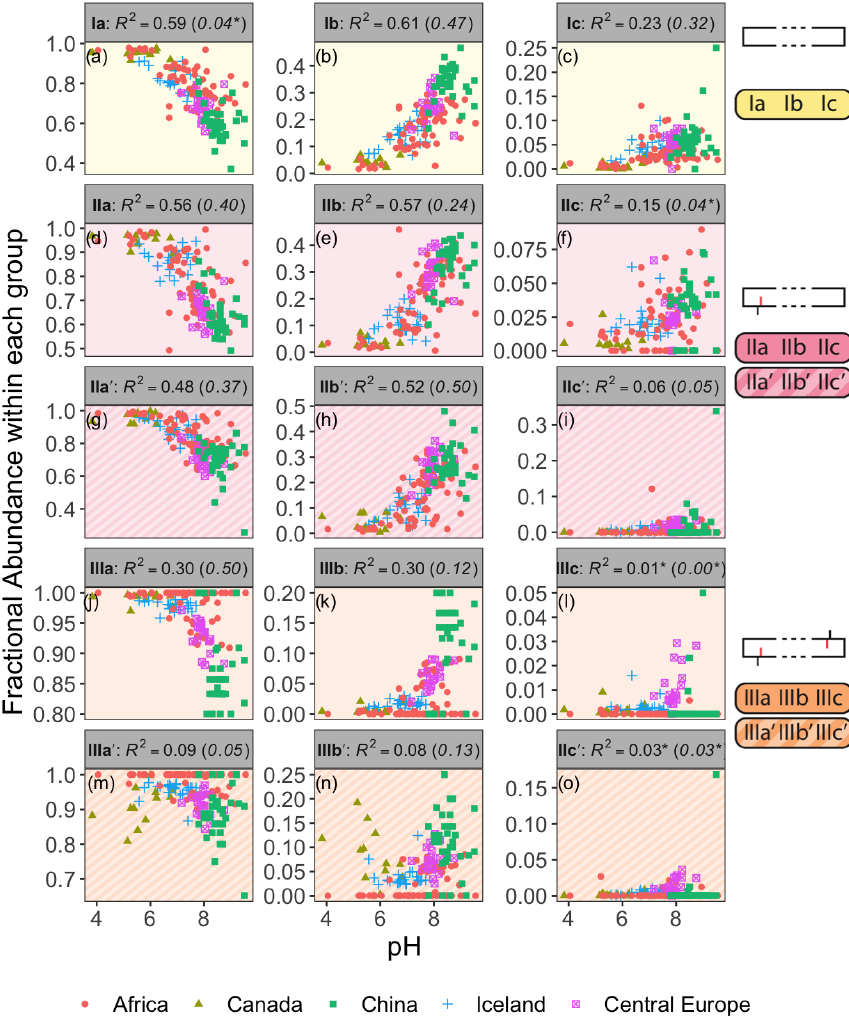
Figure 9. Relationships between pH and brGDGT FAs calculated within the Cyc set. R 2 values are provided for each subplot, with R 2 values for the standard Full FAs given in parentheses for comparison. P values were < 0.01 except where marked with an